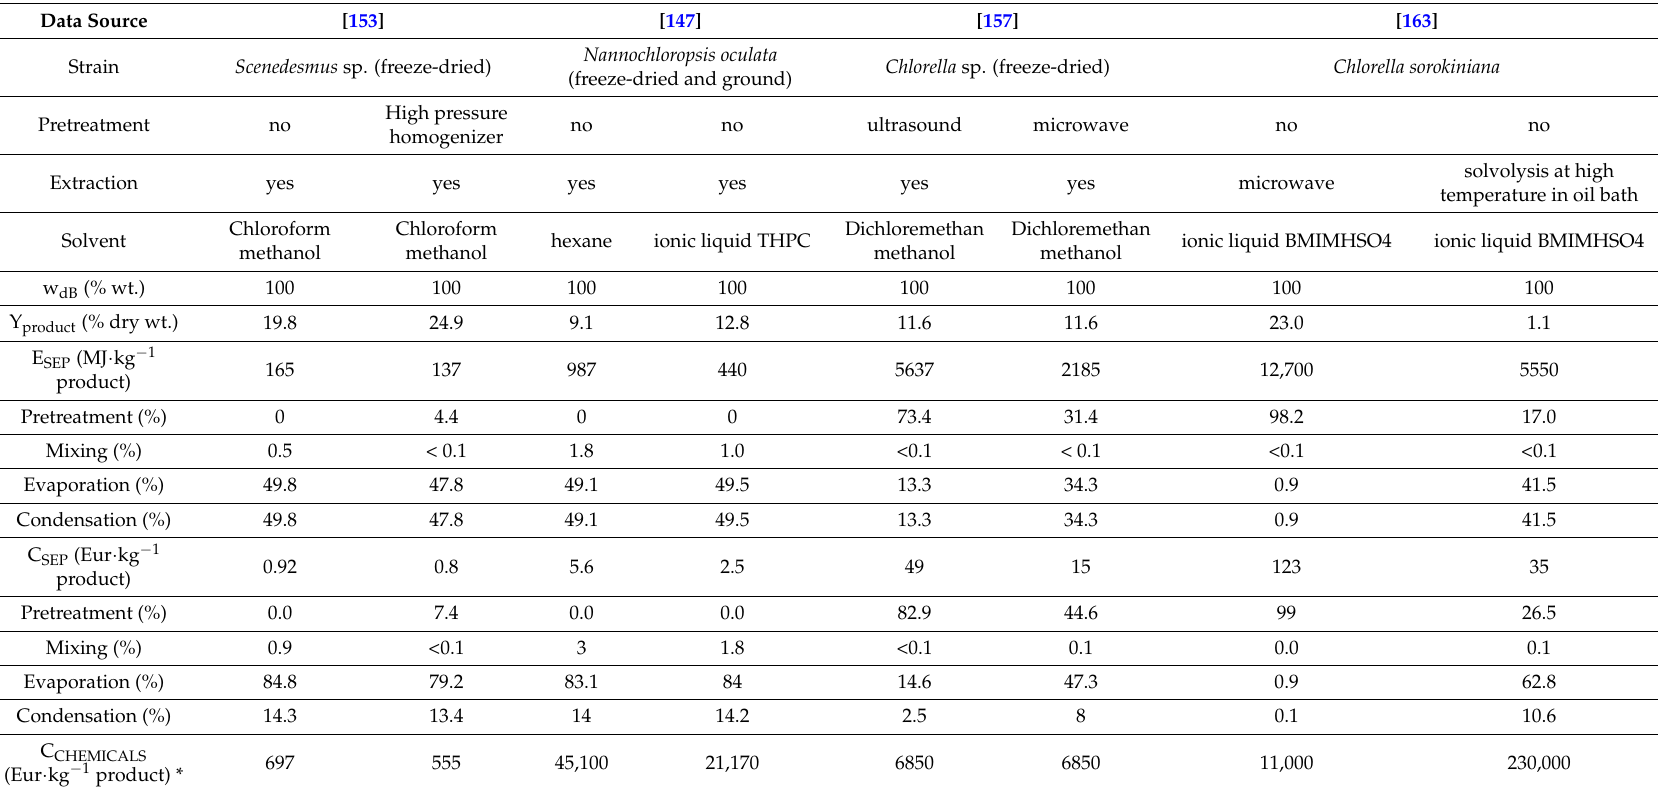
Table 3. Energy requirement, energy and production costs for lipid